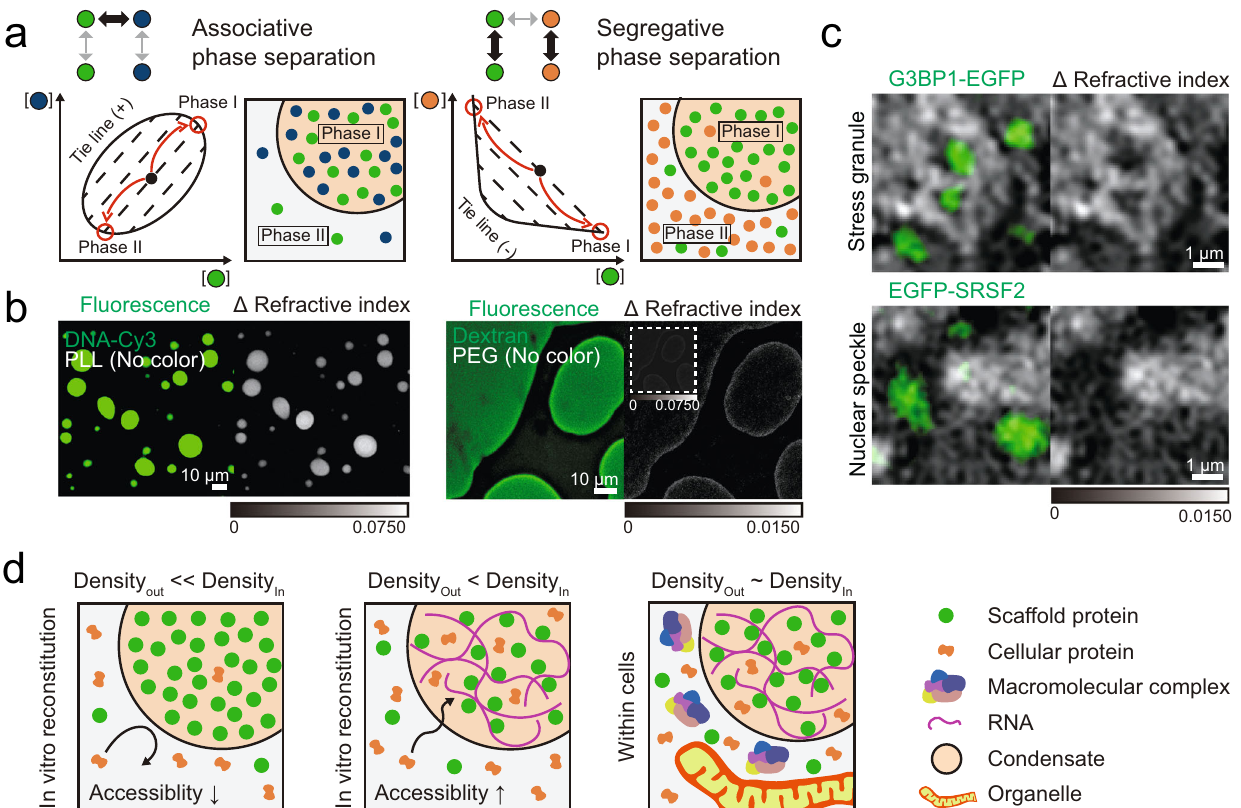
Fig. 6 | Demixing transition of low-density condensates in living cells. a Schematics of phase diagrams for associative- (left) and segregative phase separation (right). In the simple ternary systems, different intermolecular interac- tions can give rise to immiscible phases of distinct compositions, which can be represented in terms of phase diagrams. The ternary mixtures with initial compo- sitions labeled as black dots undergo phase separation along the tie line to form two immisciblephases. b (Left) Representative fl uorescenceand Δ RIimages ofthe mixture of DNA and poly-l-lysine (PLL). The mixture contains 89.5 μ M DNA phos- phates (10% FAM labeled) and 0.068w/v% PLL amines in 100mM NaCl buffer. (Right) Representative fl uorescence and Δ RI images of PEG-dextran aqueous two- phase system (ATPS). 5wt% TMR-labeled dextran and 4wt% PEG are used in the ATPS system. The inset image is adjusted to the range of Δ RI 0 – 0.075 for com- parison with the DNA-PLL image. Δ RI images are obtained by subtracting the